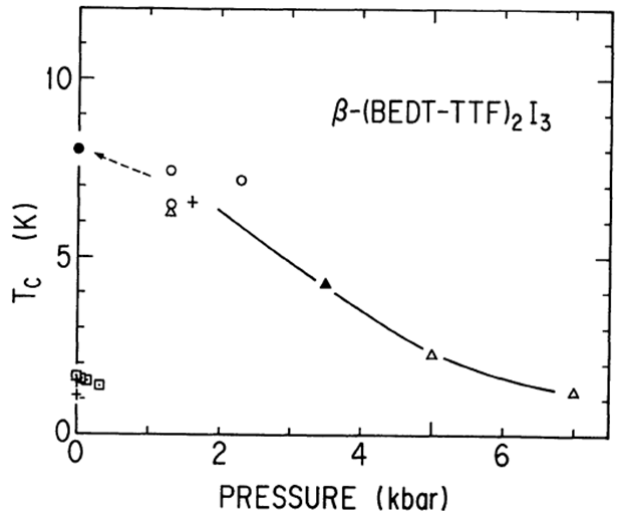
’s, i.e. , inner structure of superconductivity was suggested. c were proved related to the structure c